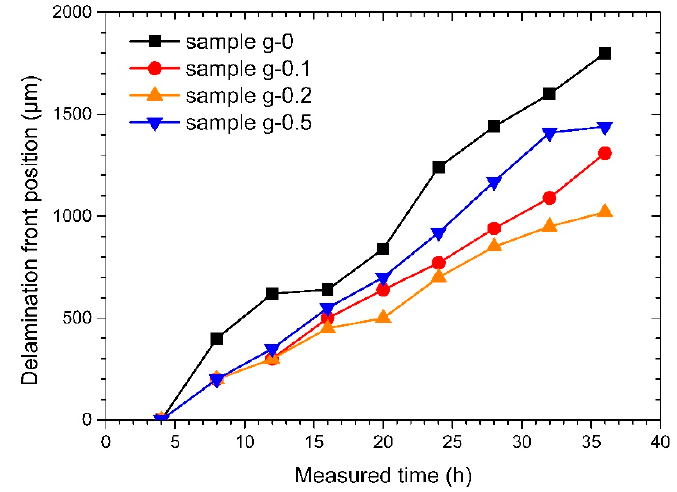
Figure 7. Delamination front positions of acrylic composite coated carbon steel samples with different fGO contents as a function of time, determined from the SKP potential profiles presented in Figure 6.